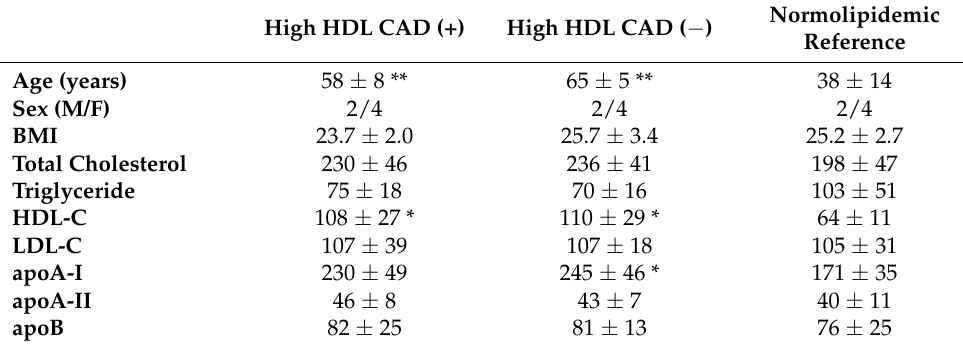
Table 1. Age, sex, and plasma lipid and apolipoprotein data for subjects with high HDL with (+) and without (−) CAD as well as normolipidemic subjects. n = 6 for each group. Units for lipid and apolipoprotein parameters are mg/dL. Data are displayed as mean ± SD. Differences among groups were determined using ANOVA followed by a Tukey-HSD post-hoc test.